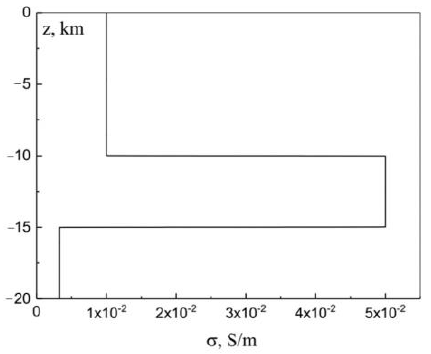
Figure 2. Dependence of the lithosphere conductivity on the vertical